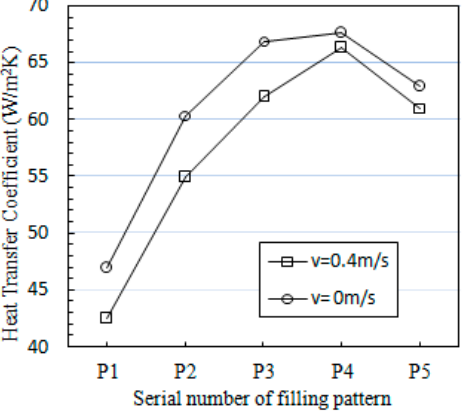
Figure 5. Relationship curves between heat transfer coefficient and filling layout patterns under 0.4 m/s crosswind speed conditions. Operating conditions: 60 °C, 6 L/min.